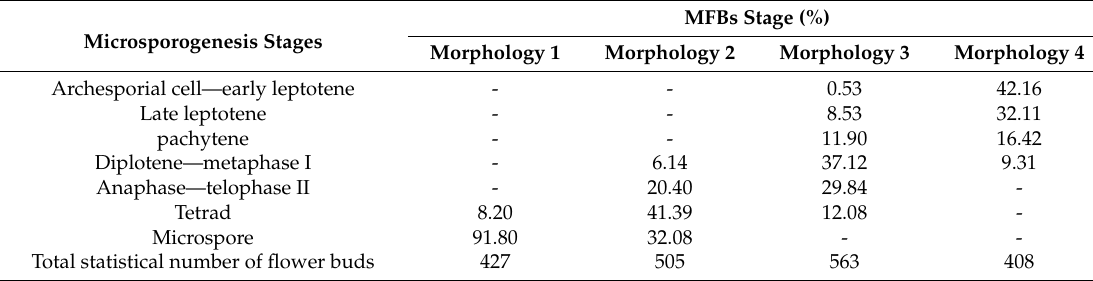
Table 2. Microsporogenesis at different MFB morphology stages in rubber tree clone RRIM